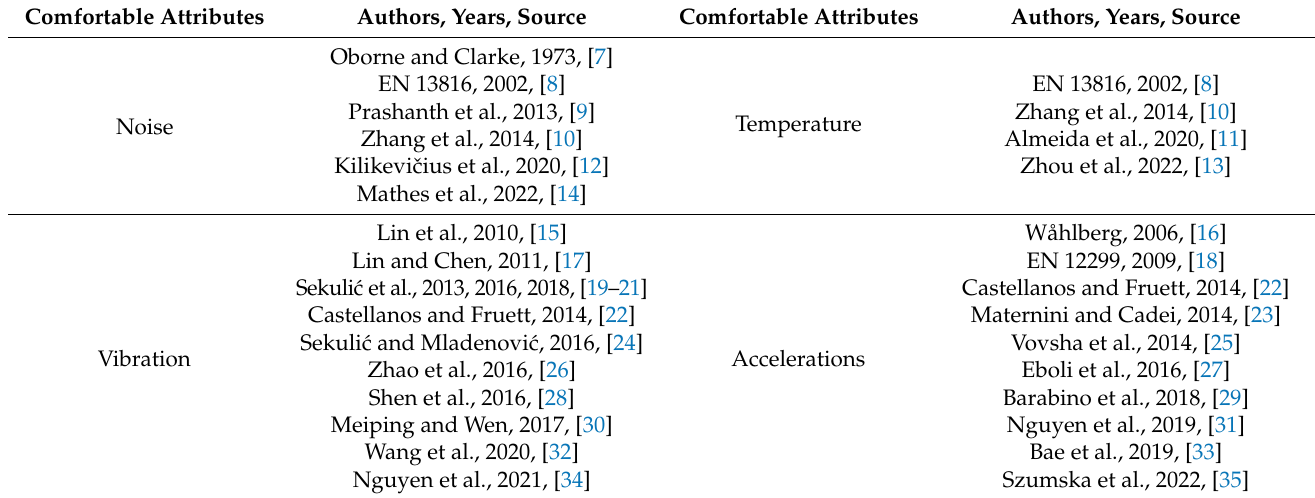
Table 1. Research on comfortable attributes influencing bus passengers in previous